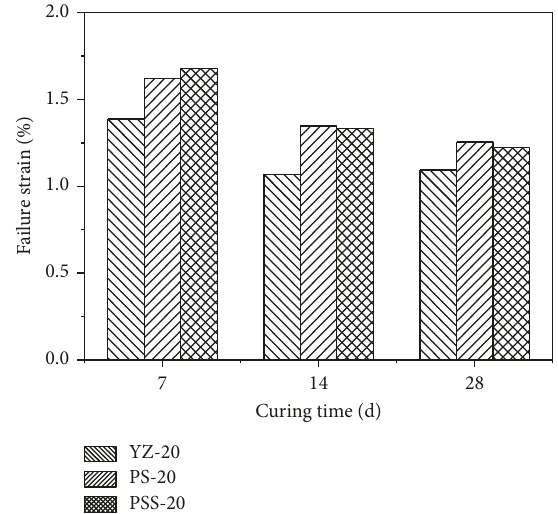
Figure 5: The failure strain of samples under different conditions (mixture ratio and curing